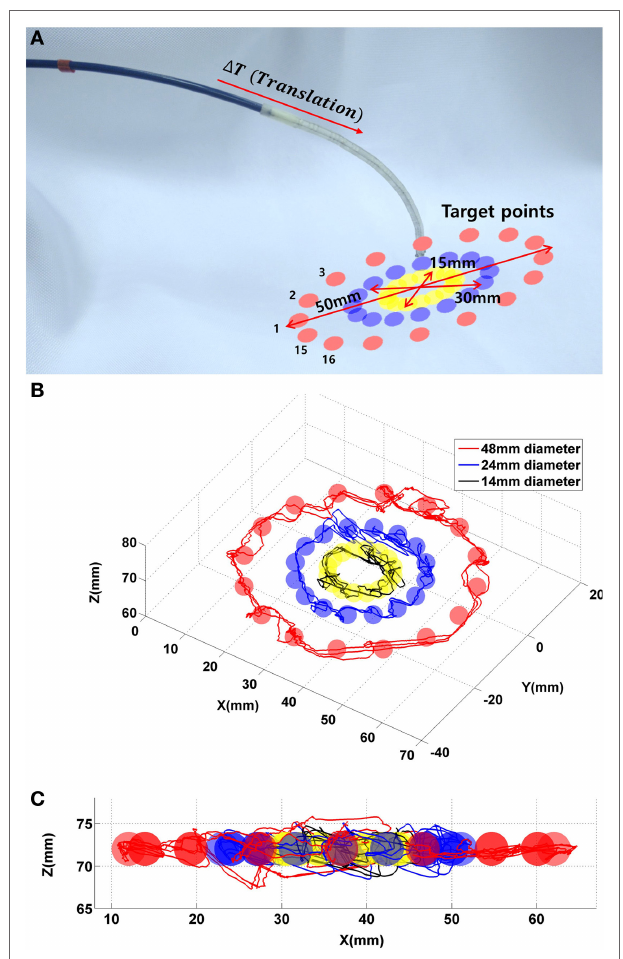
FigUre 15 | (a) 48 targets in the three circles. (B) Catheter tip trajectories on the circle plane during the control evaluation experiment with three target circles. (c) Catheter tip trajectories on x – y